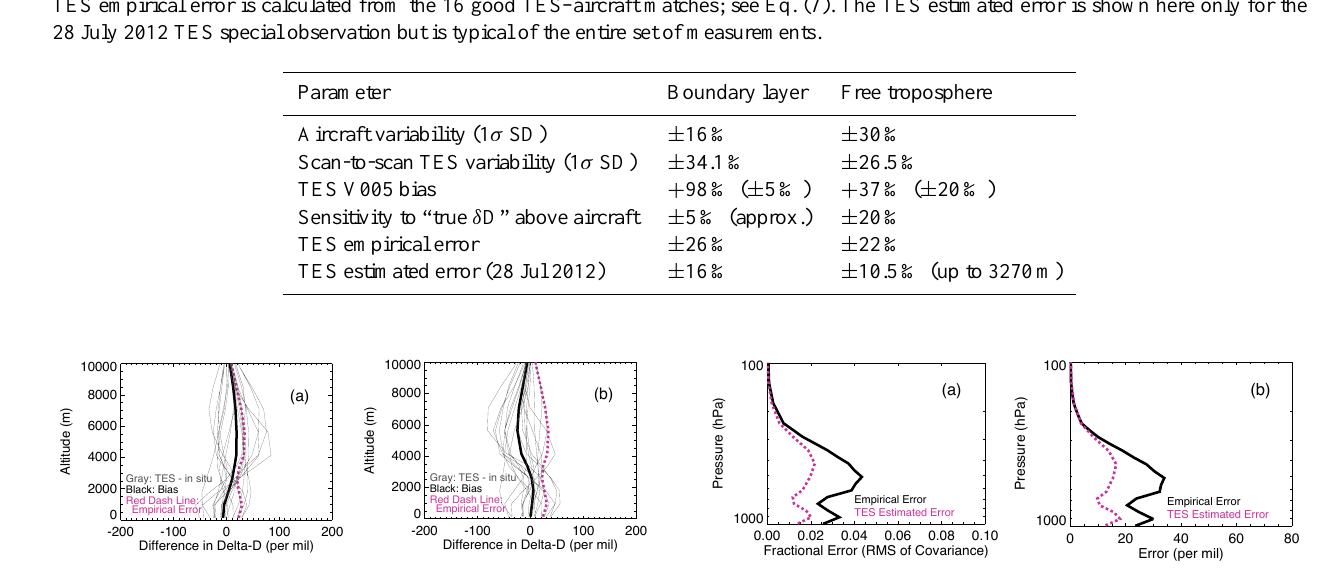
Figure 5. Sensitivity of TES δ D minus “true” δ D for different as- sumptions above the level of the aircraft measurements. Scans and constraints are the same as in Fig. 4 for the best estimate of the true δ D. (a) Comparison in which the “true” δ D is aircraft data, with scaled prior minus 30‰ above the aircraft. (b) Comparison in which the “true” δ D is aircraft data, with scaled prior plus 30‰ above the aircraft.